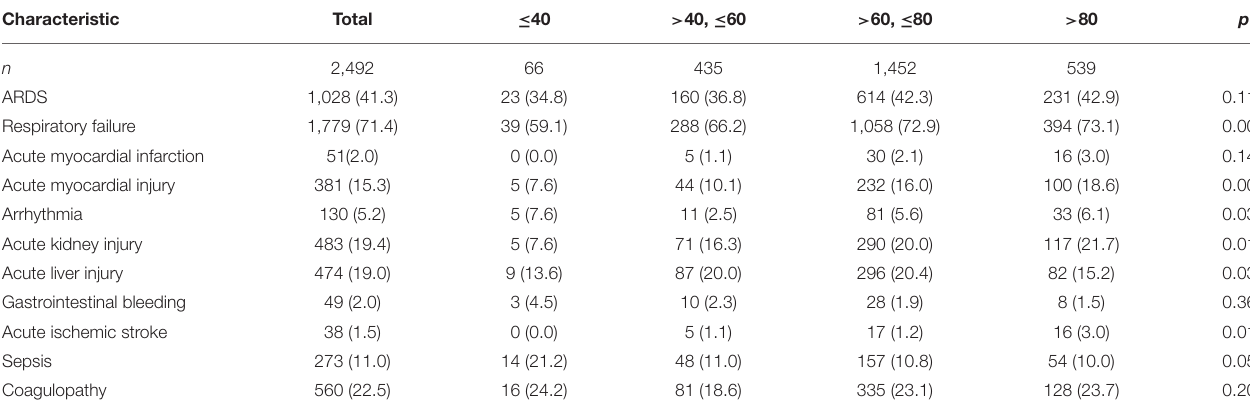
TABLE 3 | Age-related complications in deceased patients with COVID-19.